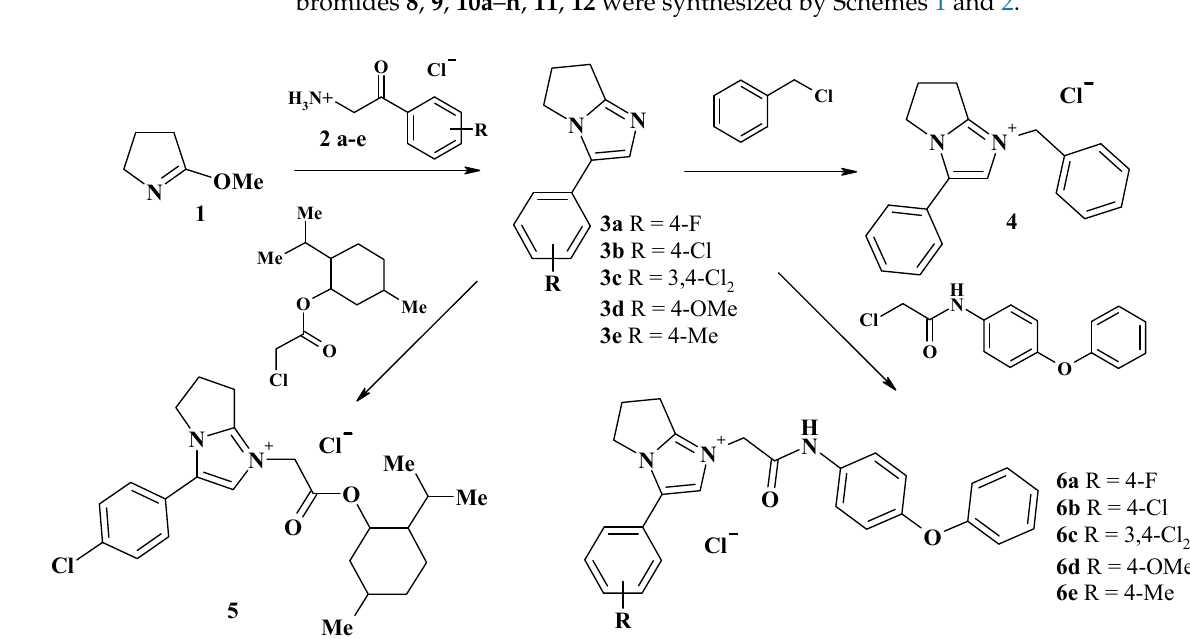
Figure 1. Background of the target compounds design.